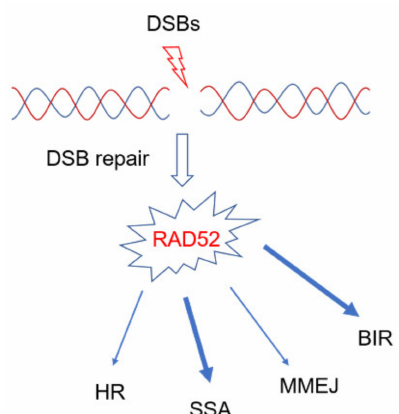
Figure 1. RAD52 is involved in multiple DNA repair pathways activated by double-strand breaks (DSBs). RAD52 is involved in di ff erent DSBs repair pathways. Mainly, RAD52 plays essential functions in single-strand annealing (SSA) or break-induced replication (BIR). MMEJ: Microhomology mediated end-joining; HR: Homologous